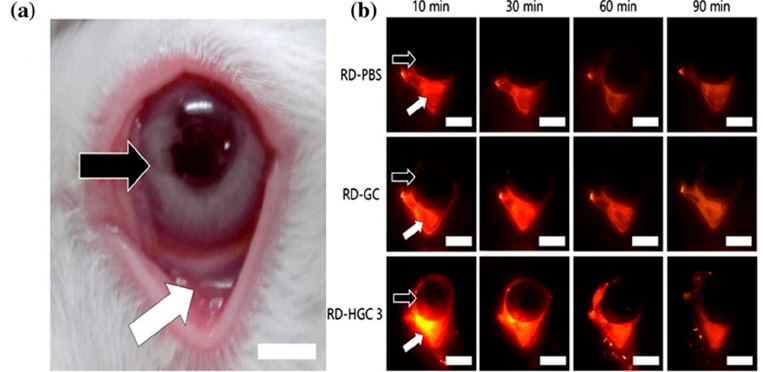
Figure 15. Photograph of rabbit eyes showing the eyeball and the inferior fornix ( a ). The fluorescence images of rabbit eyes at different time intervals after ocular administration of rhodamine-loaded PBS (RD-PBS), glycol chitosan (RD-GC) and hexanoyl glycol chitosan with 39.5 ± 0.4% degree of hexanoylation (RD-HGC 3). The eyeball and the inferior fornix (into which the formulations were administered) were shown by the black and white arrows, respectively ( b ). Scale bars = 5 mm. Reprinted from [131] with permission of Elsevier.